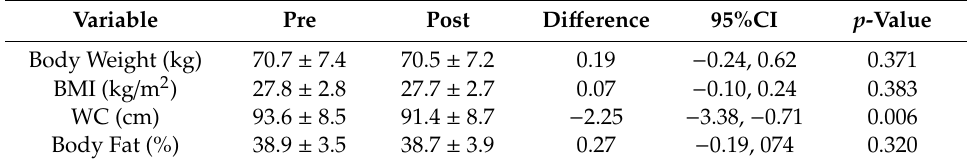
Table 1. Anthropometric and body composition measurements pre- and post-dancing intervention. Values are presented as mean ± SD, n =